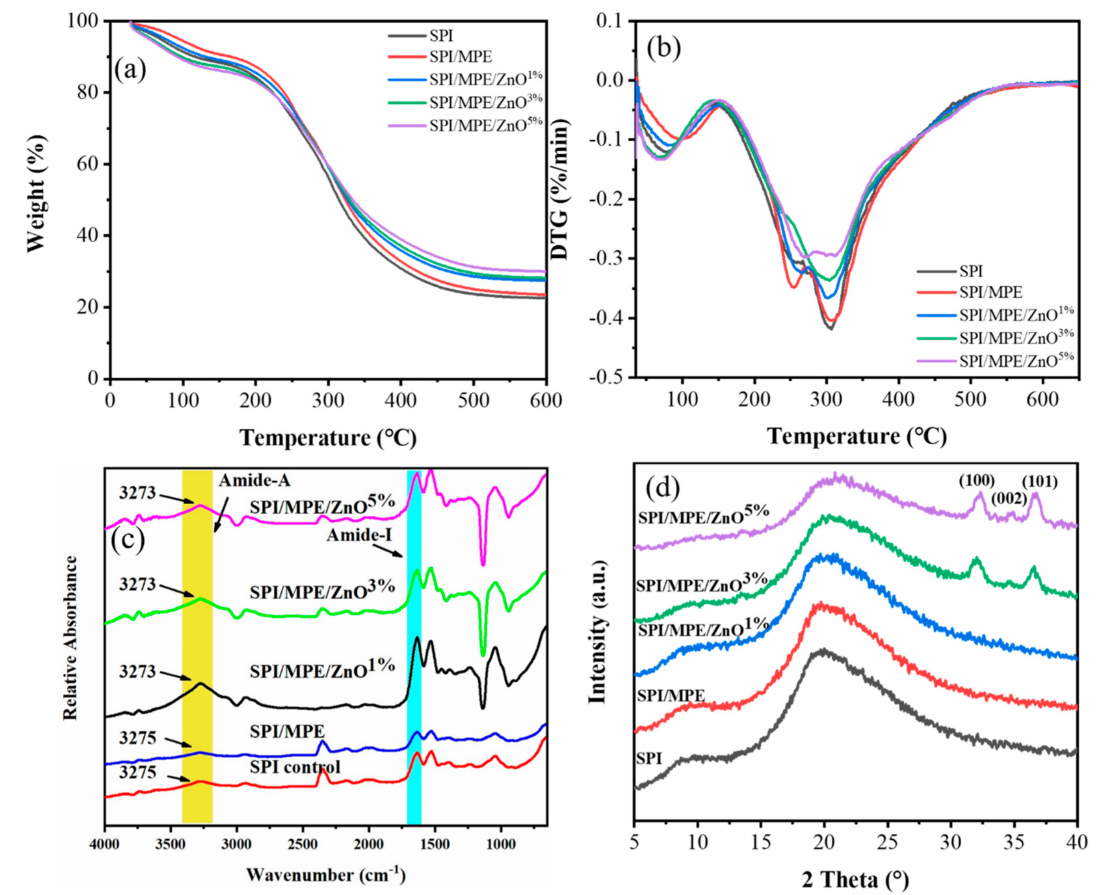
Figure 5. TGA ( a ) and DTG ( b ) profiles of SPI films. ATR-FTIR spectra of SPI films ( c ). XRD patterns of the SPI films ( d